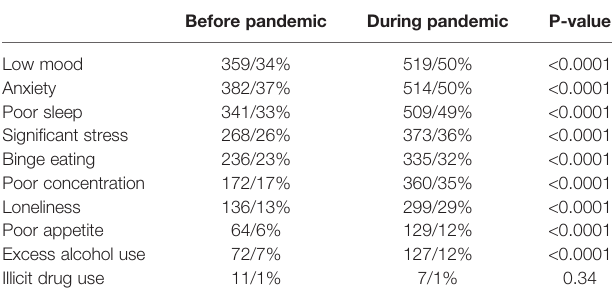
TABLE 5 | Mental health symptoms.